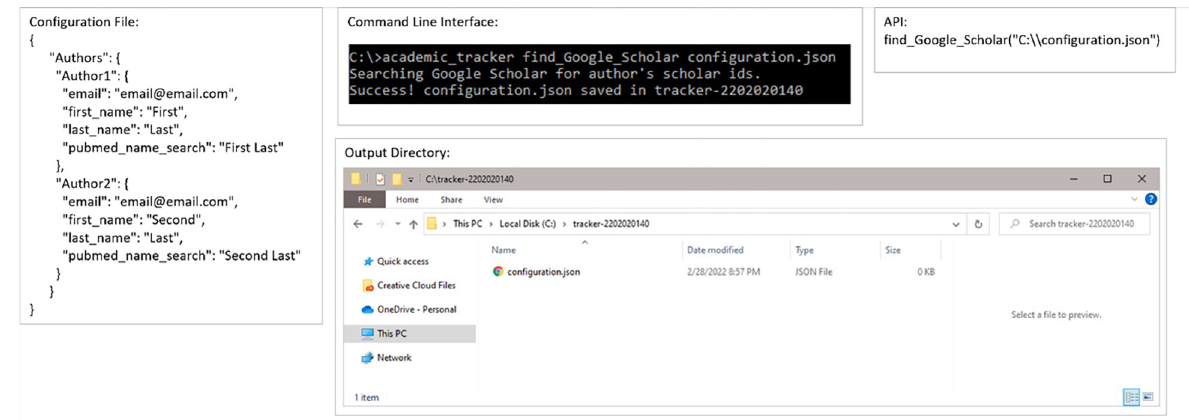
Fig 11. Example execution of the Google Scholar ID search use-case. Example configuration file, command-line execution, API execution, and file output of the author Google Scholar ID search use-case shown.